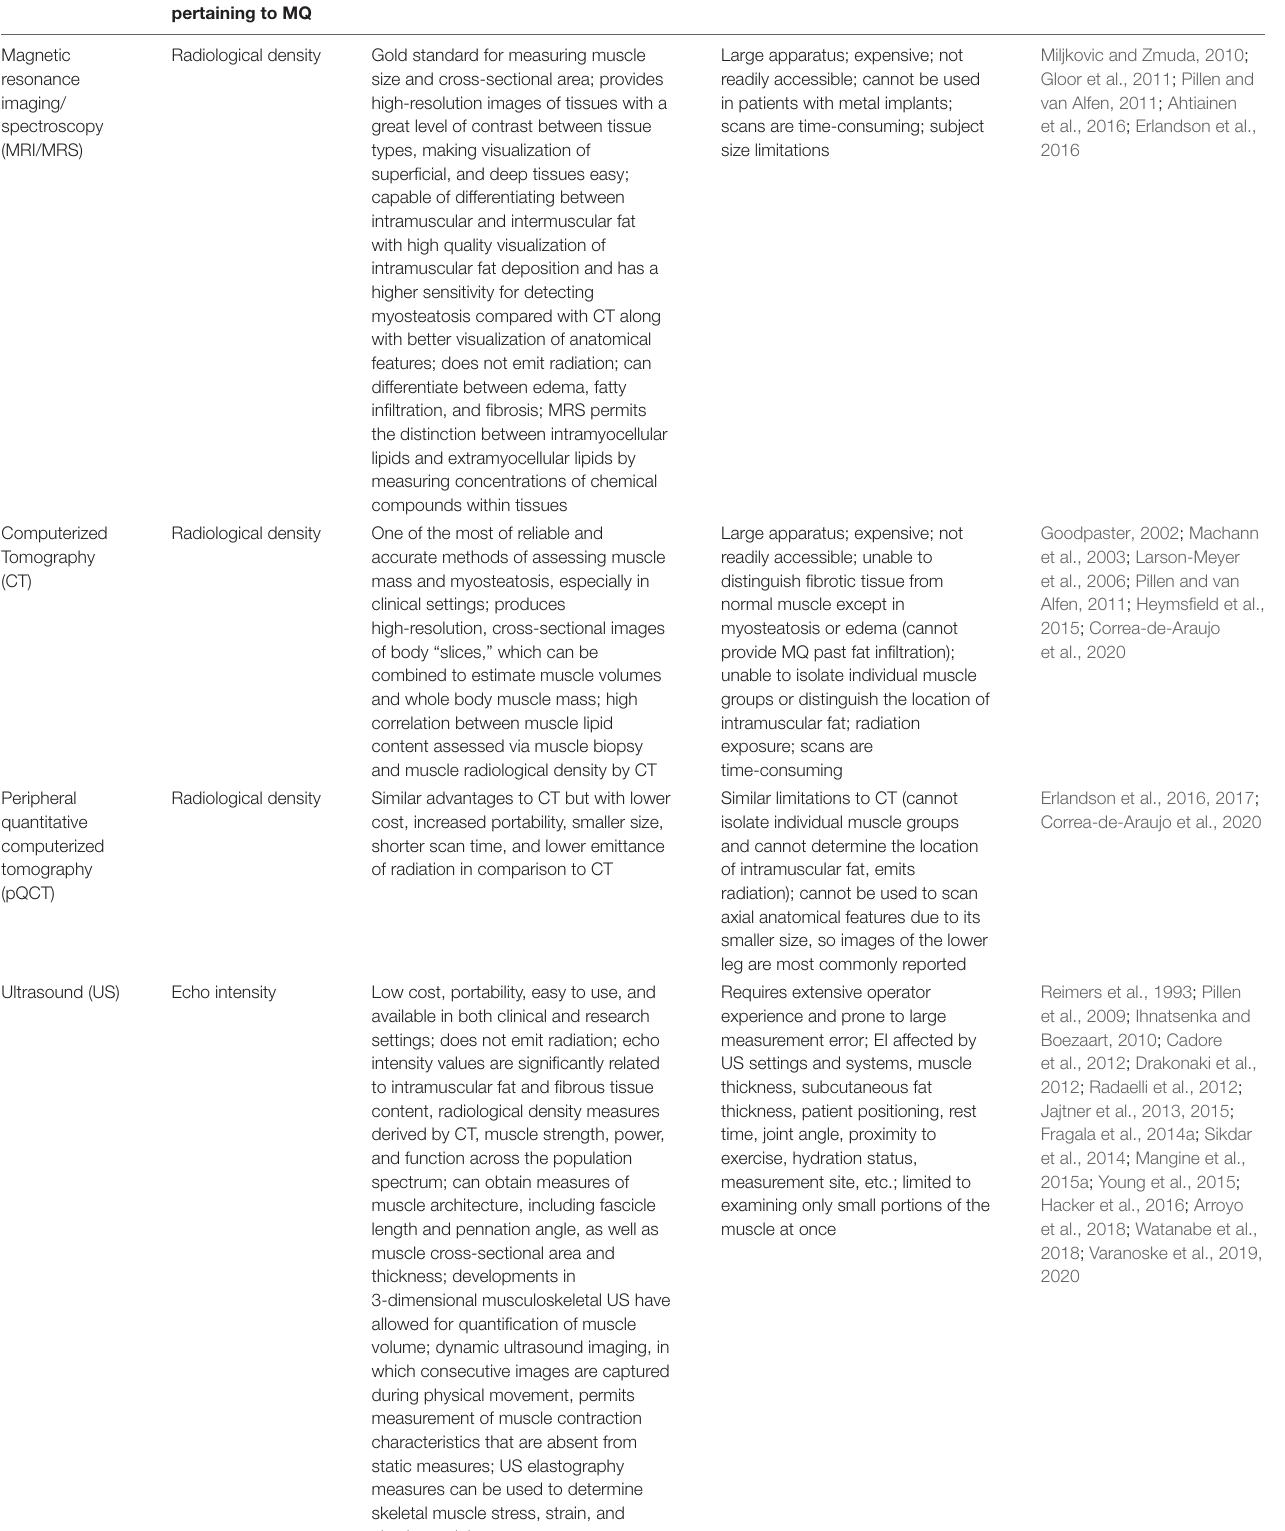
TABLE 2 | Imaging methods of assessing MQ commonly reported in the